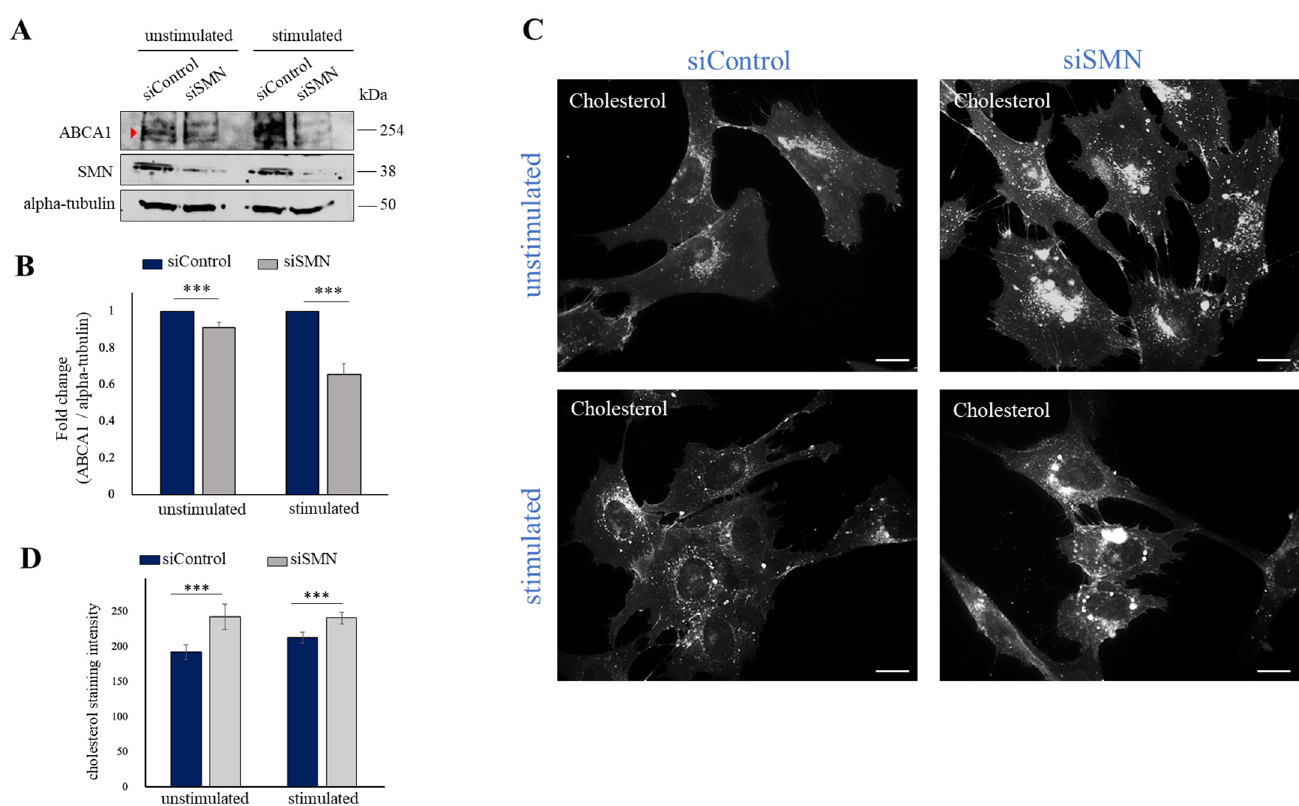
Figure 3. SMN deficiency down-regulates ABCA1 protein levels and causes intracellular accumulation of cholesterol. ( A ) Representative Western blot analysis of protein extracts from unstimulated and stimulated transfected cells. Equal amounts of proteins were blotted and checked for ABCA1 and SMN. Levels of alpha-tubulin were monitored as a control of protein loading. ( B ) Densitometric analysis of ABCA1 normalized to alpha-tubulin in unstimulated and stimulated siSMN transfected fi- broblasts compared with the control (siControl). The graph illustrates the means of three independent experiments. Error bars represent s.d. Asterisks indicate significant differences using unpaired t -test (*** p < 0.01). ( C ) Representative images of free cholesterol in unstimulated and stimulated transfected human fibroblasts by filipin staining. Scale bars, 10 µ m. ( D ) Cholesterol staining intensity analysis in siSMN-transfected fibroblasts compared with the control (siControl) in both unstimulated and stimulated conditions. The graph illustrates the means of cholesterol staining intensity determined by ImageJ 1.53a software. Error bars represent s.d. Asterisks indicate significant differences using unpaired t -test (*** p <